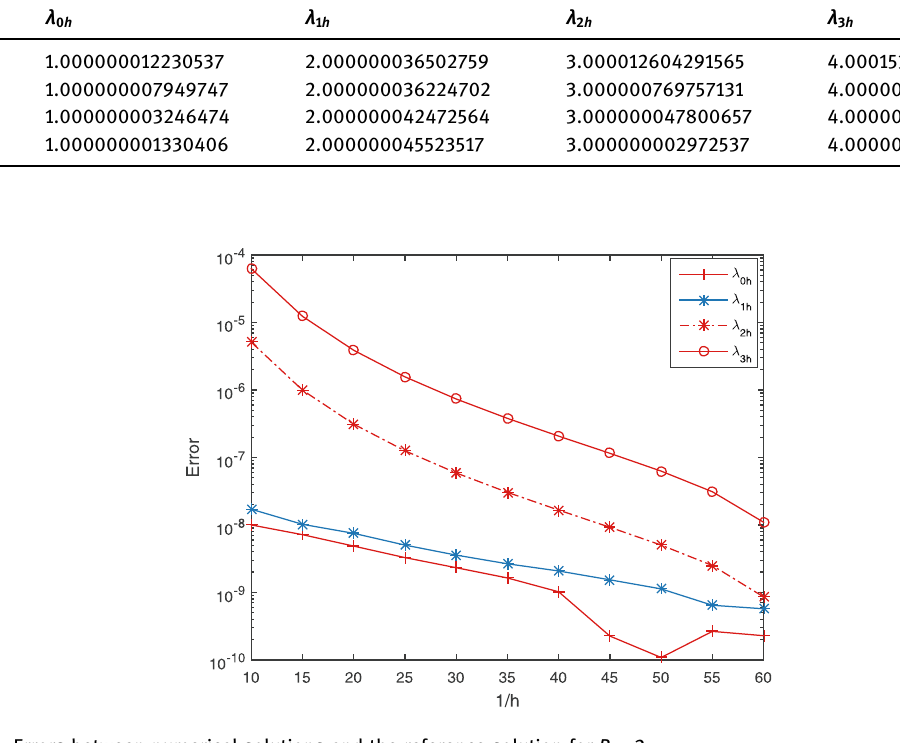
Figure 2: Errors between numerical solutions and the reference solution for = R 2 .